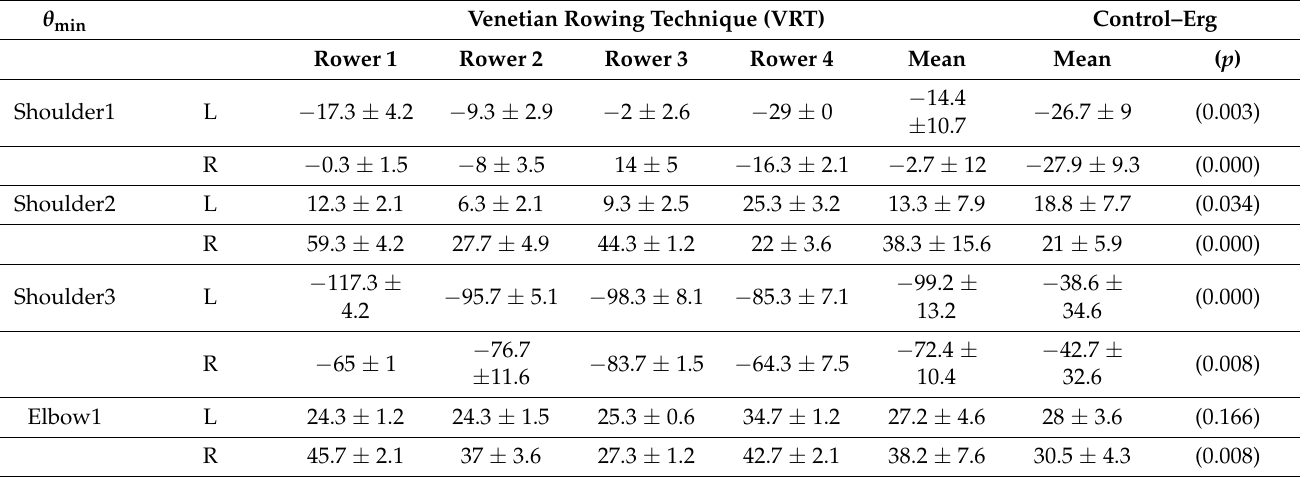
Figure 13. Angle–Angle plots which illustrate the relationship between movements in the shoulders and elbow with that of the thorax. See also Supplementary Materials for other plots. Table 8. The minimum values, θ min , of the shoulder and elbow angles measured for the Venetian style rowing technique, in degrees, ± 1 s.d., for the individual rowers 1–4, their mean, and its equivalent mean value for standard ergometer rowing, with p -value for these two means reported in parentheses.